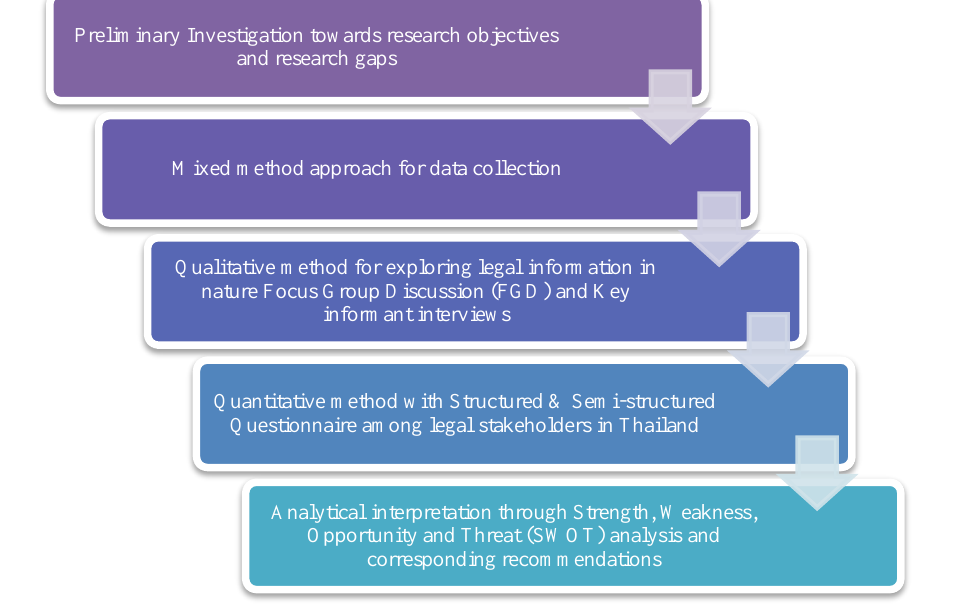
Figure 2. Conceptual framework for methodical flow of the research Table 2. Methodological approach towards this